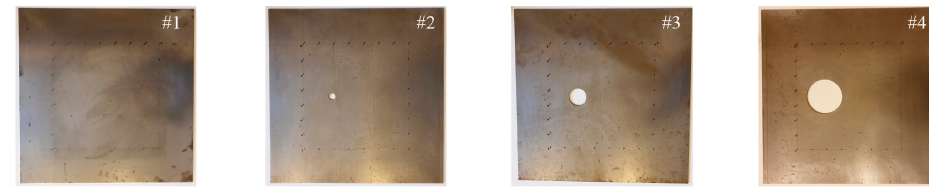
Figure 3. Photographs of tested plates (models #1–#4).